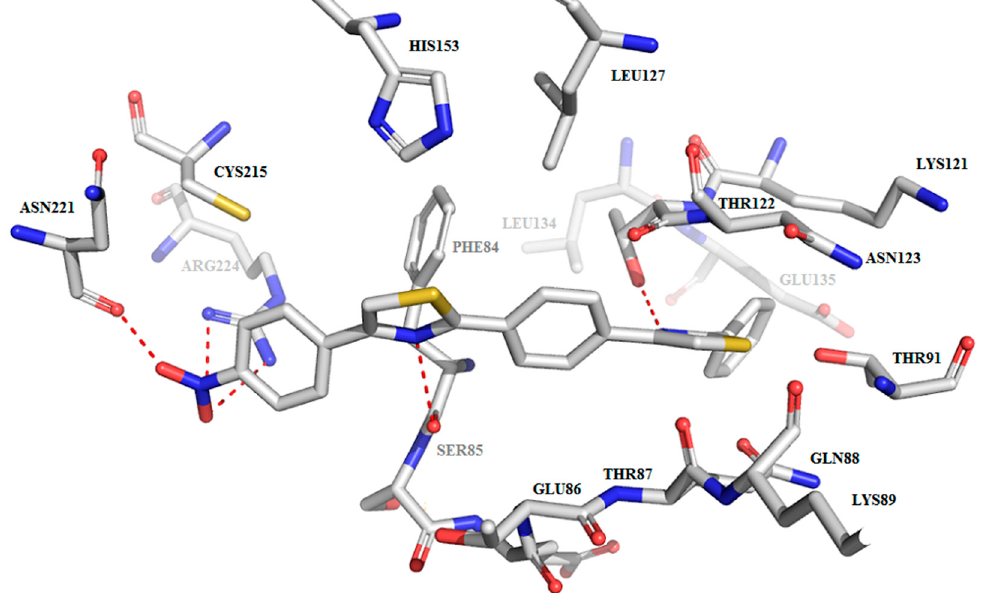
Figure 6. Compound C3 ’s predicted binding mode to the active site of EfSRT_29212 E. faecalis Sortase A. Active site and the ligands are depicted as sticks. The hydrogen bonds are depicted as dashed redlines.